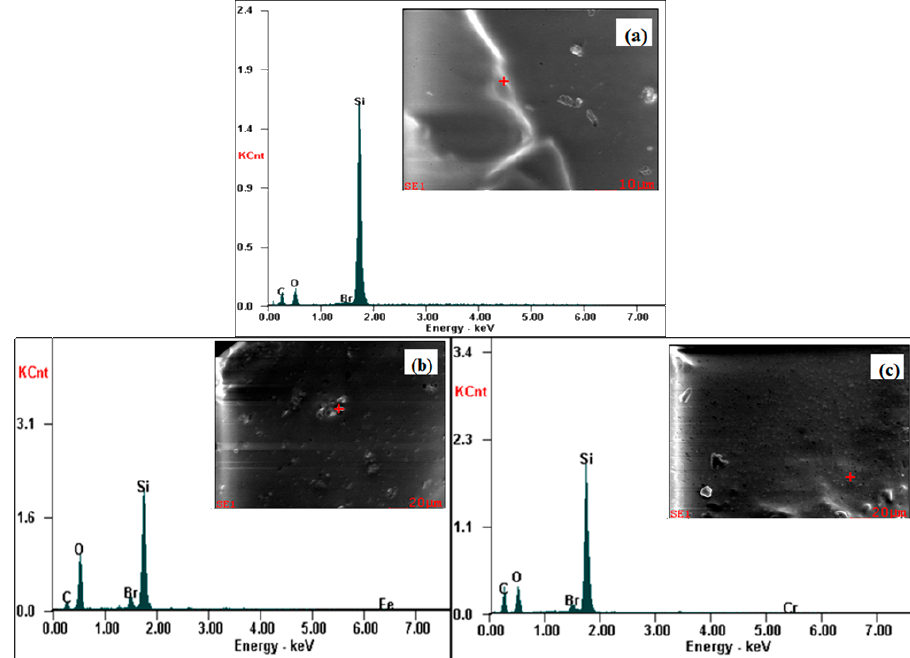
Figure 1. SEM and EDX data for samples: ( a ) RS2; ( b ) C1S2 15%; ( c ) C2S2 15%.